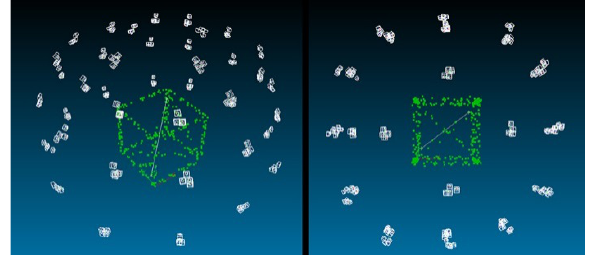
Figure 2. Image positions. Left – iso view, right – top view.